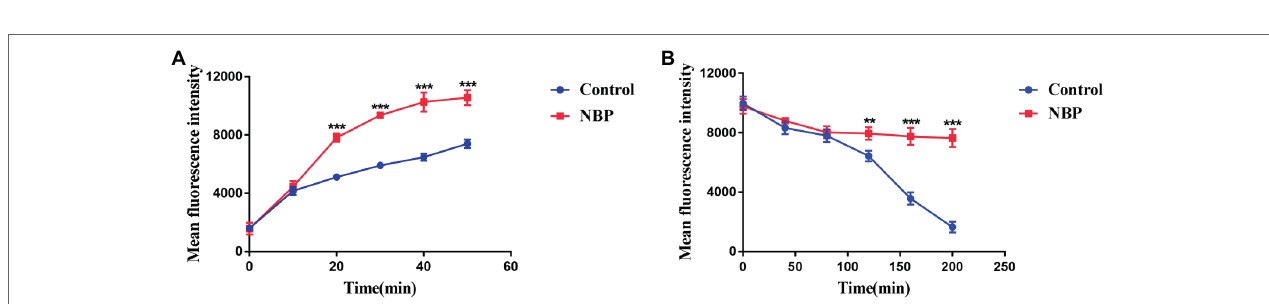
FIGURE 7 | Effect of NBP on the Δ ψ m of C. albicans. Yeast cells pretreated with diverse concentrations of NBP (0, 32, 64, and 128 μg/ml) for 4 h were incubated with 15 μM Rh123 and then analyzed by a flow cytometer. (A–D) Effect of different doses of NBP on Δ ψ m loss in C. albicans. (A) Negative control, (B) 64, (C) 128, (D) 256 μg/ml. Representative images from three independent experiments are shown. The percentages of cells in the left section of the histogram refer to the number of cells with depolarized mitochondria. (E) Effect of NBP on the mean fluorescence intensity of Rh123-stained C. albicans . *** p < 0.001 compared with the control group (one-way ANOVA).